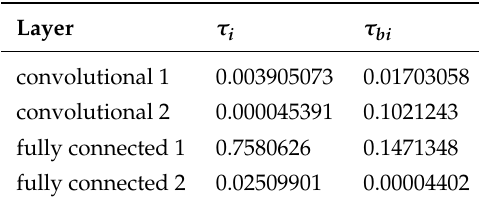
Table 3. A posteriori